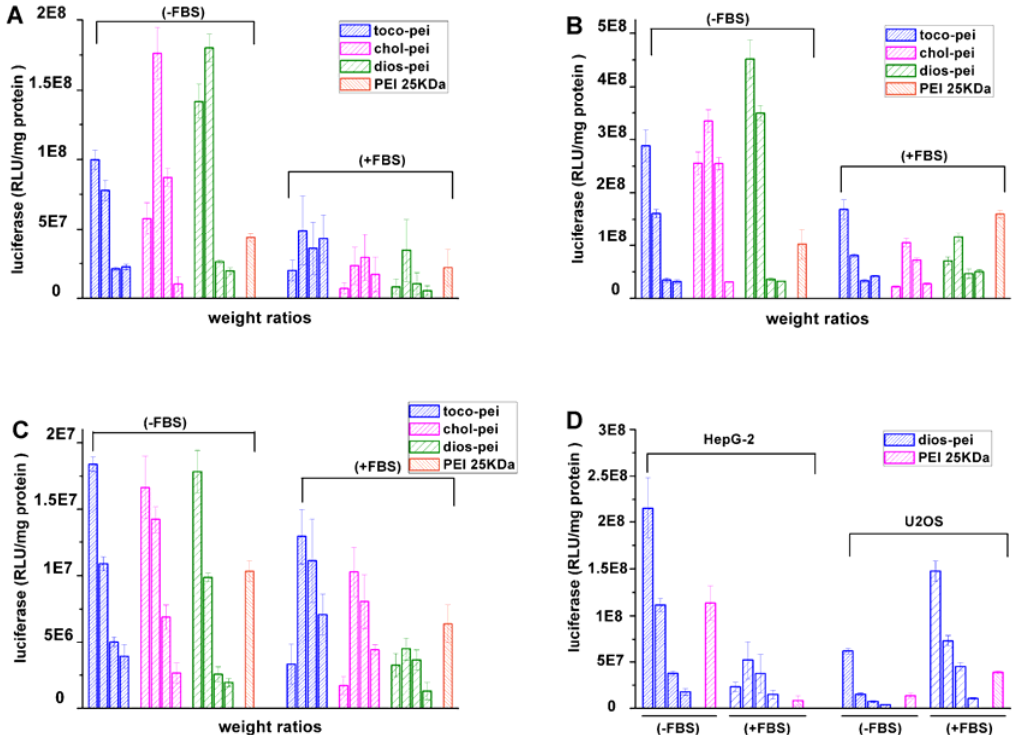
Figure 10. Luciferase expression transfected by lipopolymer/DNA polyplexes at various w / w ratios (3.2, 6.4, 9.6, or 12.8) in HeLa ( A ), HEK293 ( B ), and MCF-7 ( C ) cells with serum-free or 10% serum-containing medium. ( D ) dios-pei /DNA polyplexes at different w / w ratios (3.2, 6.4, 9.6, or 12.8) in HepG2 and U2OS cells in the absence and presence of 10% serum. All experiments used 25-kDa PEI/pGL-3 ( w / w = 1.4) for comparison (mean ± SD, n = 3).